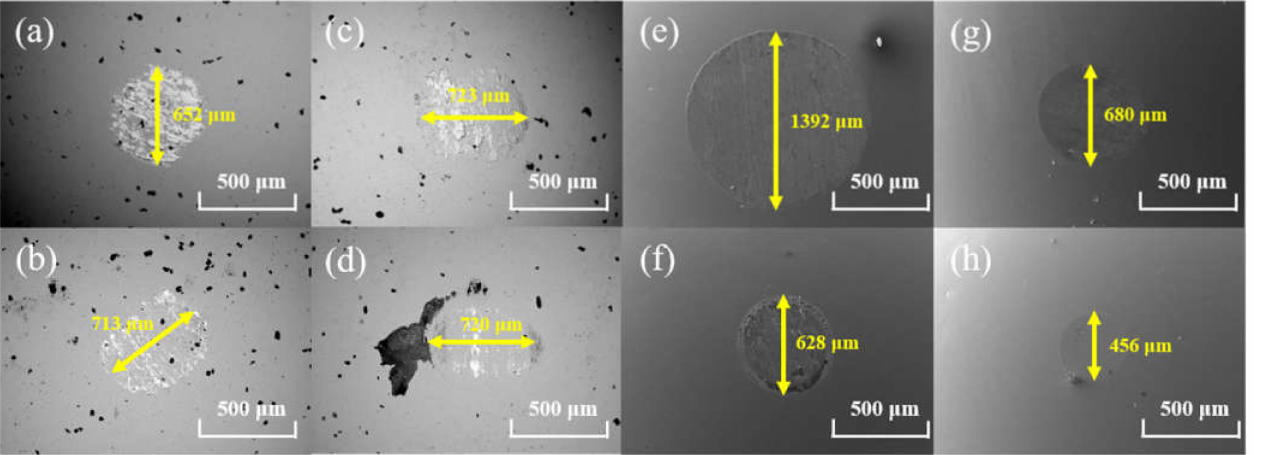
Figure 8. Morphology of the wear area of friction pairs under SEM: ( a ) Zr-4 alloy, ( c ) Cr coating, ( e ) CrN coating, and ( g ) Cr 2 N coating, under unlubricated conditions; ( b ) Zr-4 alloy, ( d ) Cr coating, ( f ) CrN coating, and ( h ) Cr 2 N coating, under water-lubricated